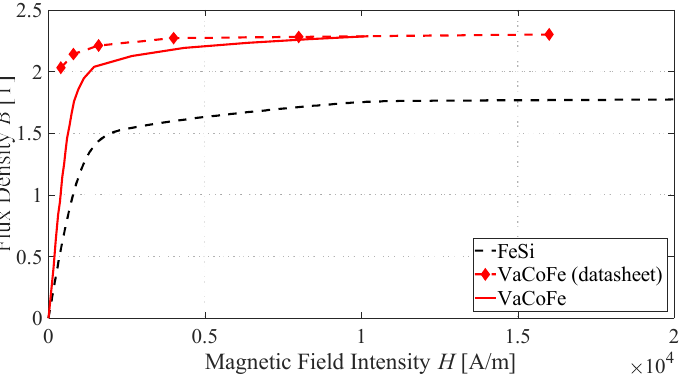
Figure 1. Magnetic circuit used in the experimental tests made from VaCoFe. ( a ) Magnetic circuit dimensions with half of the average path, l , (dashed line), and ( b ) core and windings’ identification.